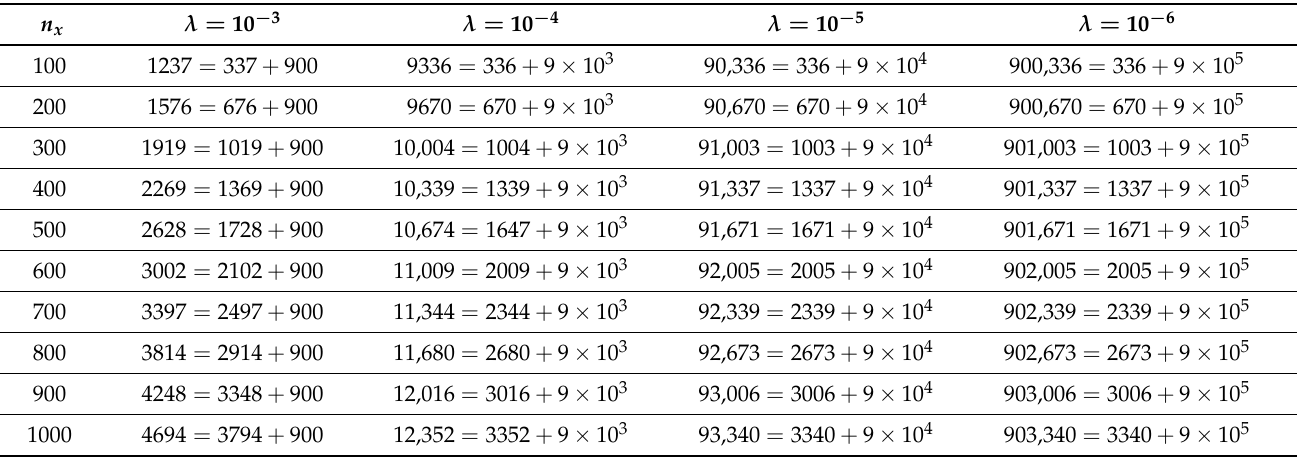
Table A2. Fastest eigenvalue Λ max as λ decreases for different n x , λ , and constant N = 2. For a visualization, see Figure 5.